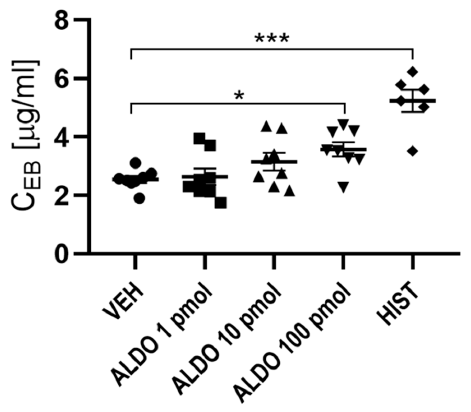
Figure 2. Dose-dependent effect of ALDO on vascular permeability. n = 6–8; n for each group is the number of skin samples, not the number of animals; 10 rats were used in this experiment; data are presented as mean ± SEM and individual values; HIST was used as a positive control. ALDO— aldosterone; C EB —Evans blue concentration per gram of skin tissue; HIST—histamine; VEH—ALDO solvent; * p < 0.05; *** p < 0.001.